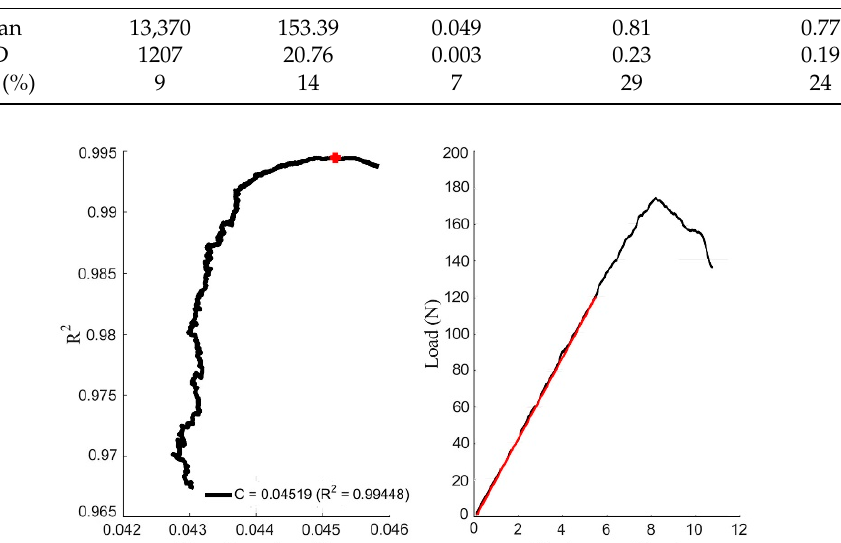
Figure 4. Macroscopic images of crack propagation: “DCB 176-3 RL” (left); “DCB 192-2 TL” (right).